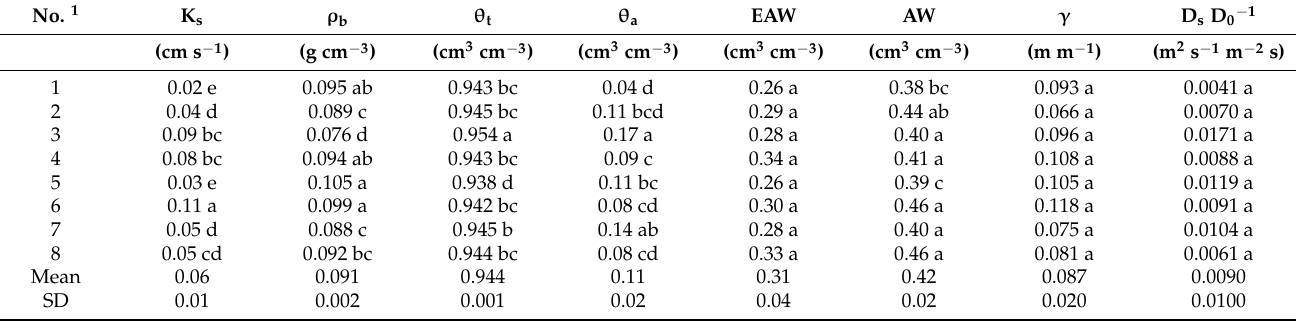
Table 2. Physical properties of substrates from eight forest nurseries after po tt ing.